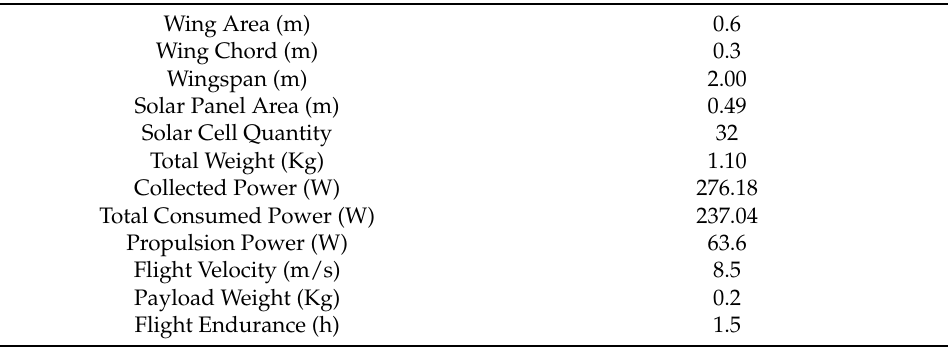
Table 9. Aircraft optimized output